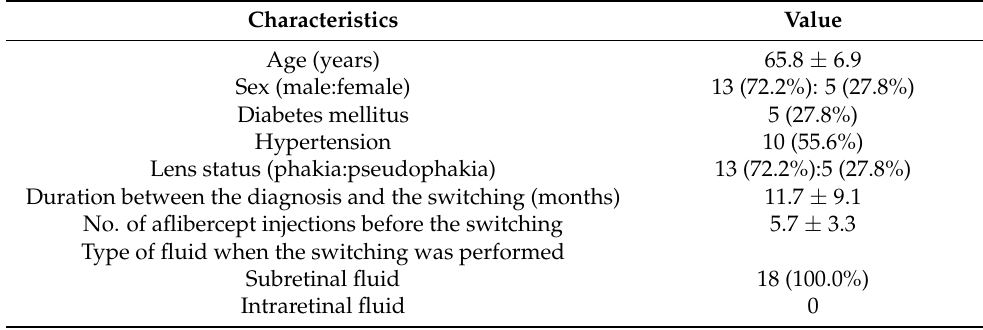
Table 1. Baseline characteristics of patients ( n = 18) with aflibercept-resistant polypoidal choroidal vasculopathy included in the trial.